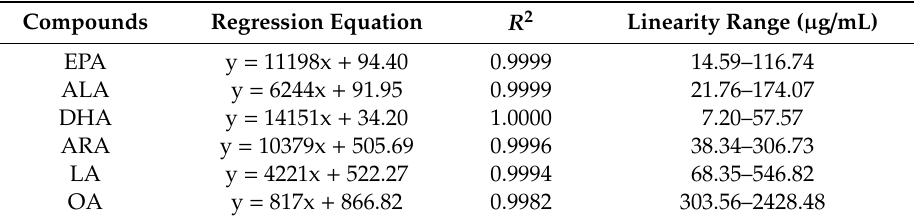
Table 2. Regression equation of six kinds of PUFAs standards.